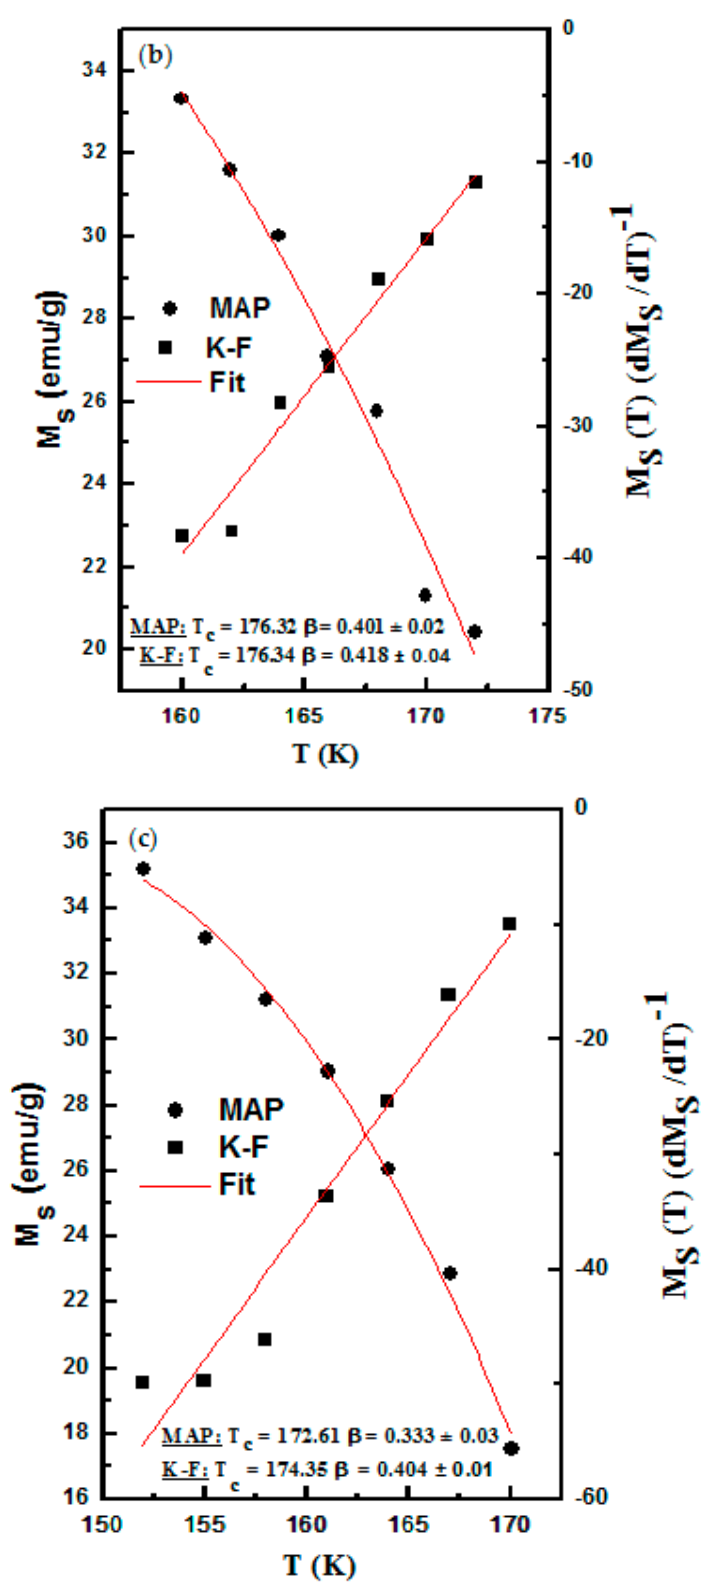
Figure 7. The spontaneous magnetization Ms ( T ) as a function of temperature, along with fits (solid curves) based on the power laws (left-axis) defined by (2) and Kouvel–Fisher (right-axis) defined by Equation (5), respectively. For La 0.8 Ca 0.2 Mn 1 − x Co x O 3 , ( a ) x = 0.1, ( b ) x = 0.2, ( c ) x = 0.3.